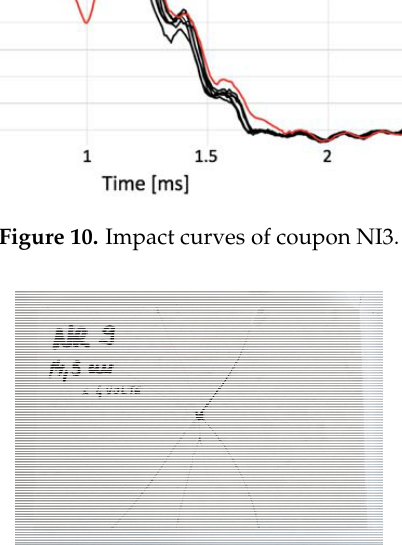
Figure 11. Example of specimen failure: NI2 after four impacts.